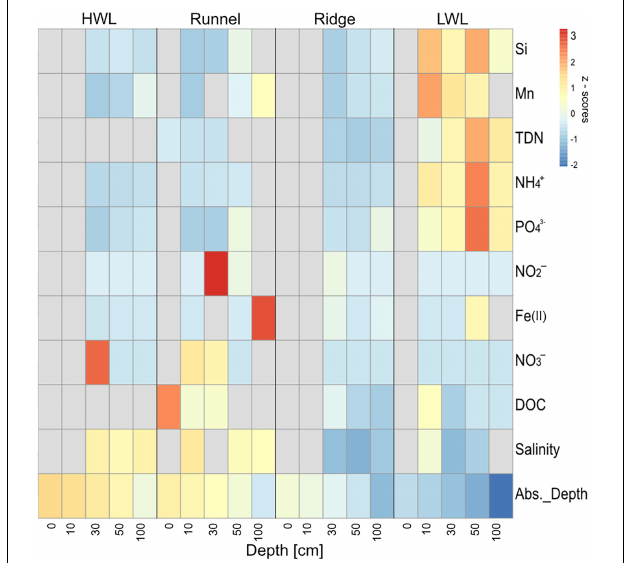
FIGURE 1 | Normalized porewater constituents (z scores) across the transect. Colder colors indicate lower, warmer colors higher z scores, respectively. Gray bars indicate missing values caused by porewater scarcity. depth, absolute depth above or below sea level; DOC, dissolved organic carbon; TDN, total dissolved